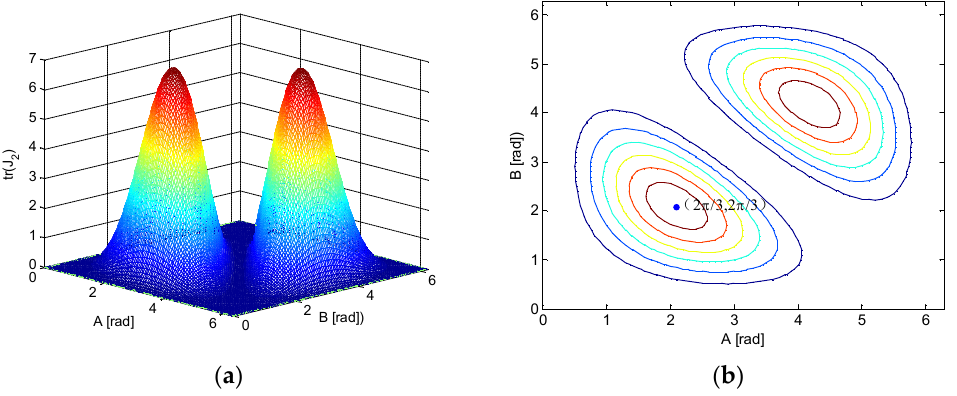
Figure 1. 3D plot of the information function Tr ( J ) for three sensors. ( a ) The value of Tr ( J ) ; ( b ) The contour plot of Tr ( J )